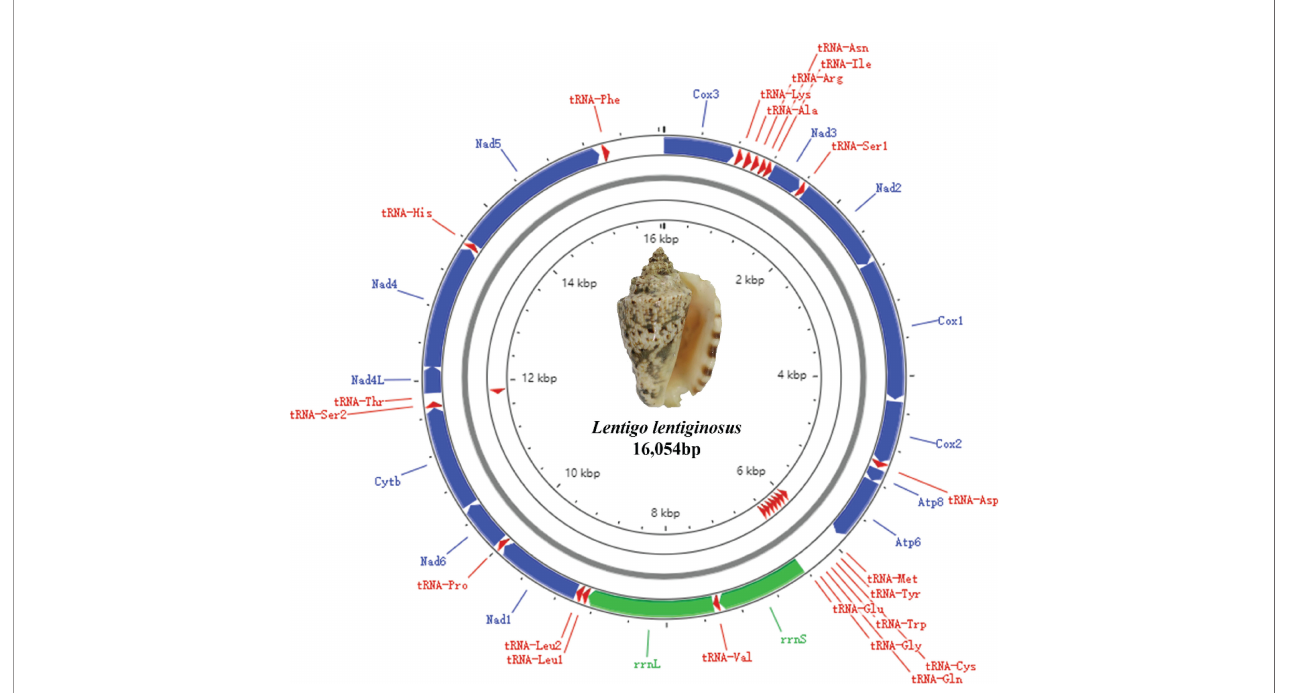
FIGURE 1 | Mitochondrial genome map of the mt genomes of strombids represented by Lentigo lentiginosus .